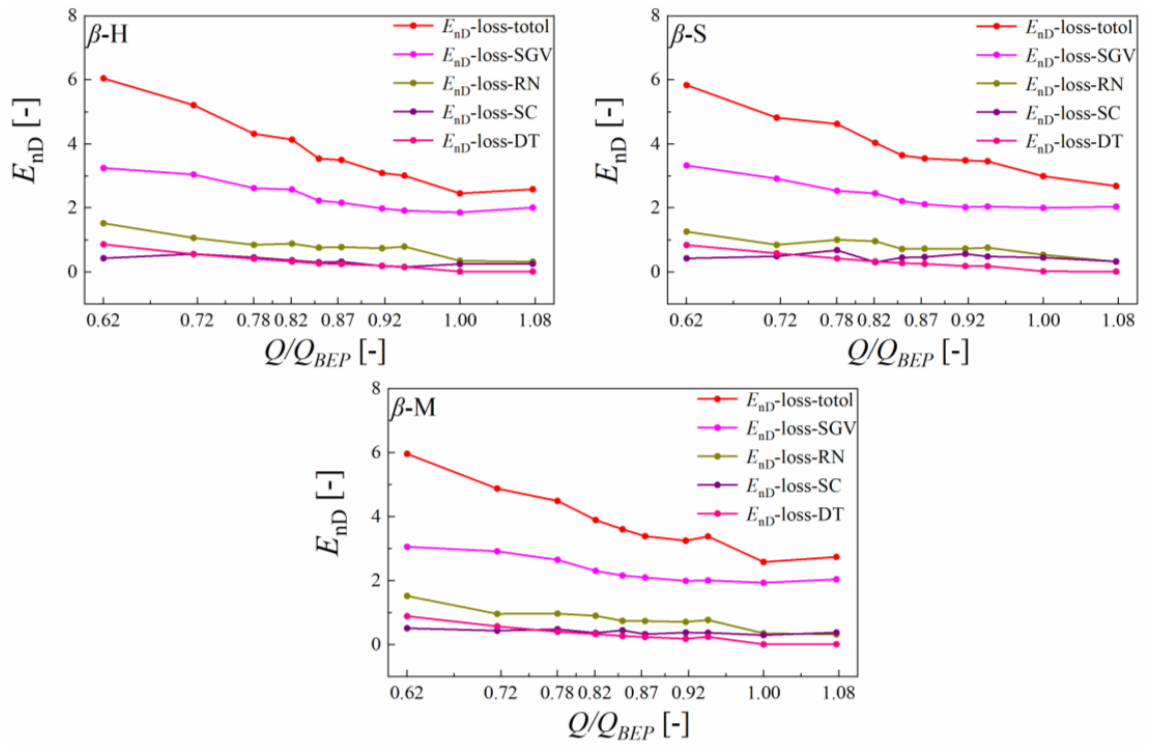
Figure 13. Distribution of hydraulic loss in 13 mm GVO.